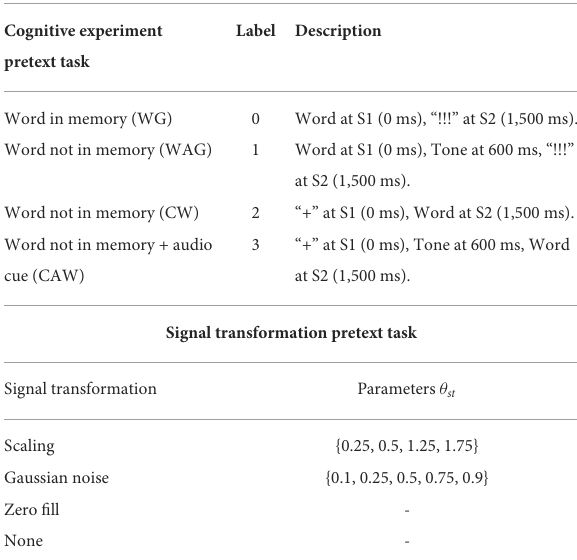
TABLE 1 Design considerations for the self-supervised pretext tasks for AU transformations and EEG cognitive